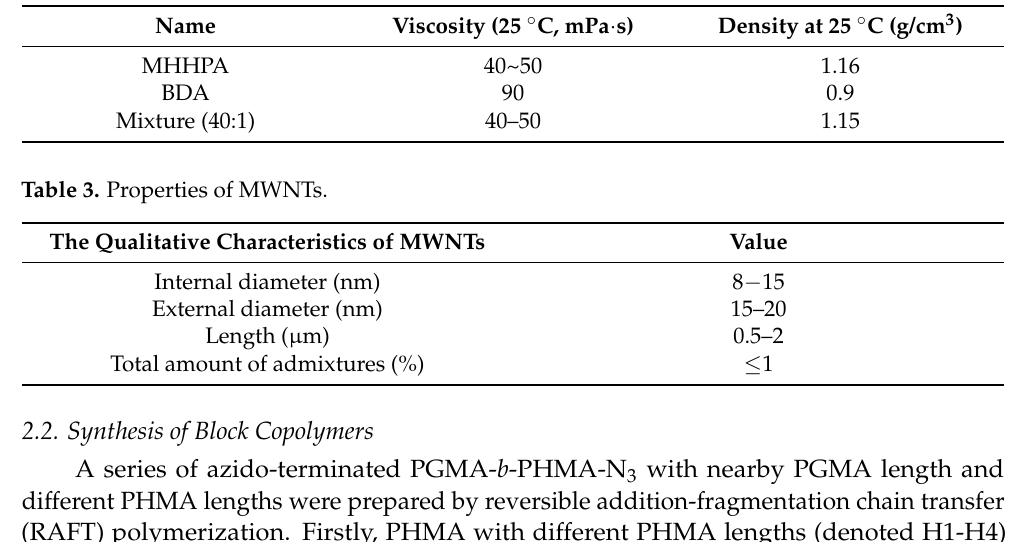
Table 2. Properties of hardener.